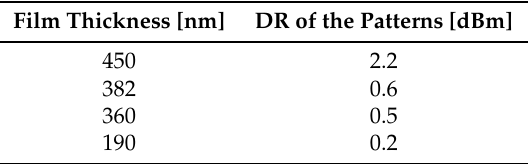
Table 1. Experimentally estimated dynamical range values in polymer films of different thicknesses.